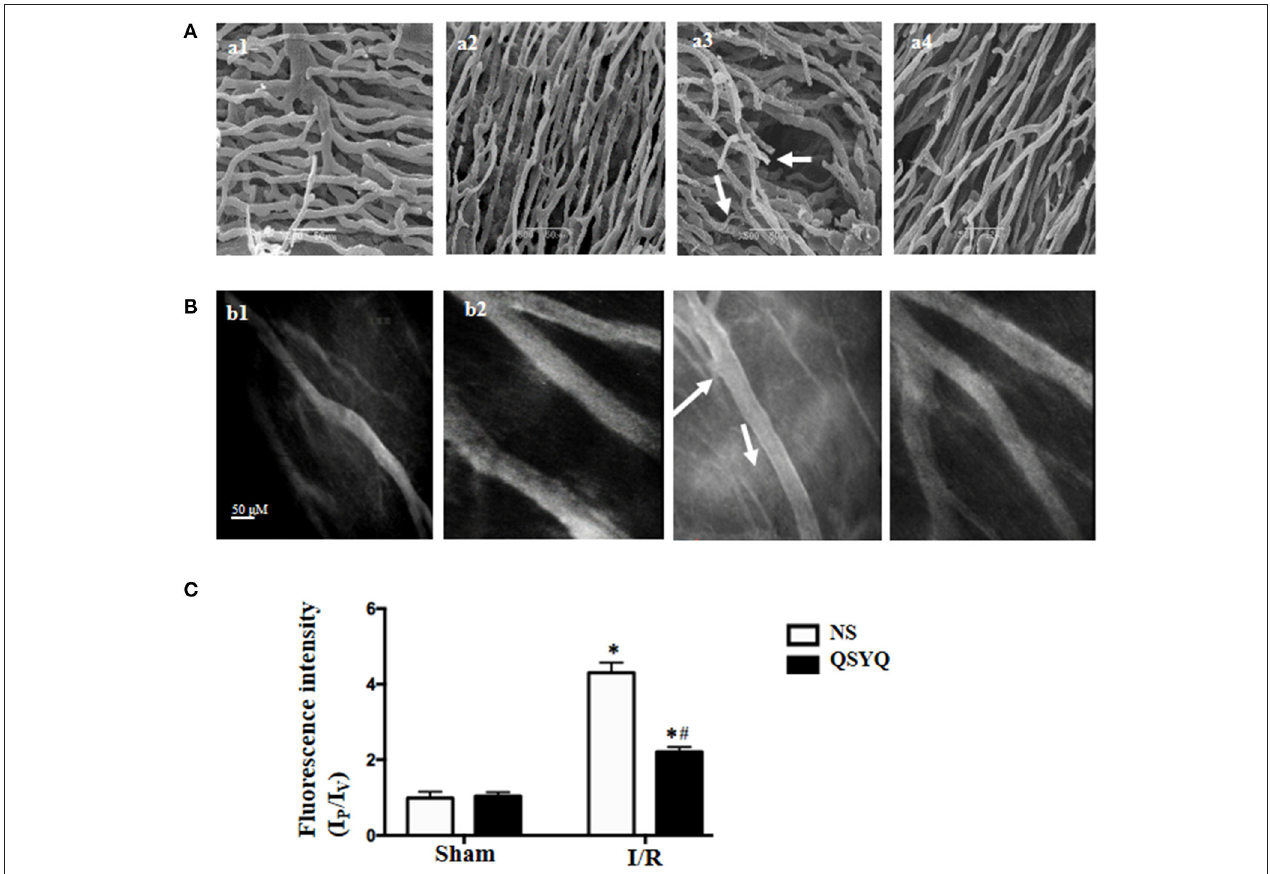
FIGURE 1 | Effect of pretreatment with QSYQ on the vascular corrosion casts and coronary venular albumin leakage of rat heart. (A) The representative scanning electron micrographs of myocardial vascular corrosion casts in different groups. Arrows: distorted and narrowed vessel segments. a1: NS + Sham group; a2: QSYQ + Sham group; a3: NS + I/R group; a4: QSYQ + I/R group. Bar = 50 µ m. (B) Representative images of FITC-albumin leakage from coronary venules in different groups. b1: NS + Sham group; b2: QSYQ + Sham group; b3: NS + I/R group; b4: QSYQ + I/R group. Bar = 50 µ m. (C) Statistical results of albumin leakage expressed as ratio of fluorescence intensity in the Ip to that Iv. Results are presented as mean ± SEM ( n = 6). * p < 0.05 vs. NS + Sham group, # p < 0.05 vs. NS + I/R group. Statistical analysis was performed using two-way ANOVA followed by Bonferroni for multiple comparisons.